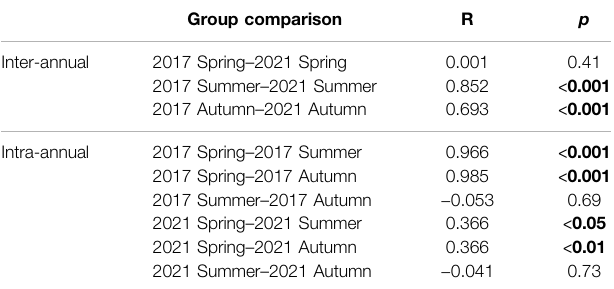
TABLE 4 | Pairwise comparisons of one-way analysis of similarities (ANOSIM) regarding signi fi cant differences of fi sh community composition in bank habitats between different years as well as before and after the dewatering of the Hammerbach. Signi fi cant differences between comparisons are indicated in bold. Group